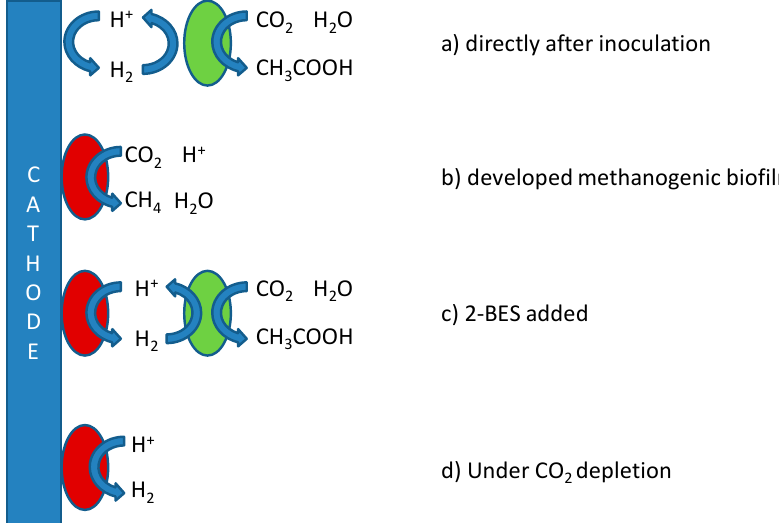
Figure 5. Proposed mechanisms as occurred under tested conditions. Red circles represent methanogenic, and green circles acetogenic bacteria. ( a ) Based on the short start-up required for acetogenesis during current controlled experiments, it is likely that electron transfer during this phase does not require the establishment of a biofilm on the electrode, but is mediated by abiotically formed hydrogen; ( b ) The gradual shift towards production of methane observed during the later phase may be caused by the establishment of a methanogenic biofilm on the electrode, which at that point outcompetes the acetogenic community for the available substrate, rendering the acetogens effectless; ( c ) Upon addition of 2-BES, the methanogenic biofilm redirects electrons to form hydrogen and the produced hydrogen is consecutively used by acetogens to produce acetate; ( d ) In the case of CO 2 depletion, all electrons are shuttled to the production of hydrogen [8].